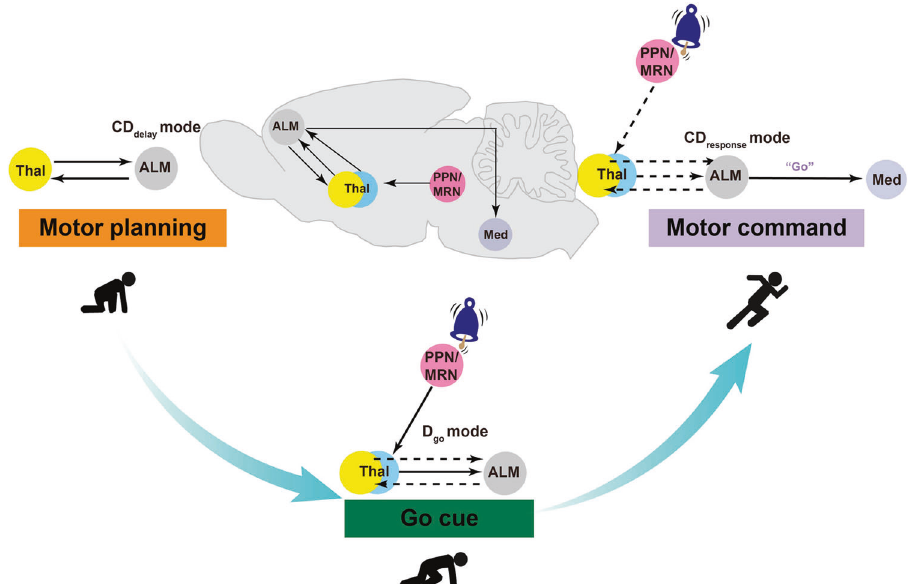
Fig. 1 Multiregional neural pathway underlying cue-triggered movement initiation. Motor planning is maintained in a thalamus-ALM circuit. The PPN/MRN receives the “ Go cue ” and then activates neurons in the thal ALM . The Go cue triggers a rapid transition from motor planning to motor command, which activates the ALM-medulla circuit to initiate planned movements. Bottom dotted lines represent the circuit involved in motor planning. Right dotted lines indicate the circuits involved in motor planning and the Go cue